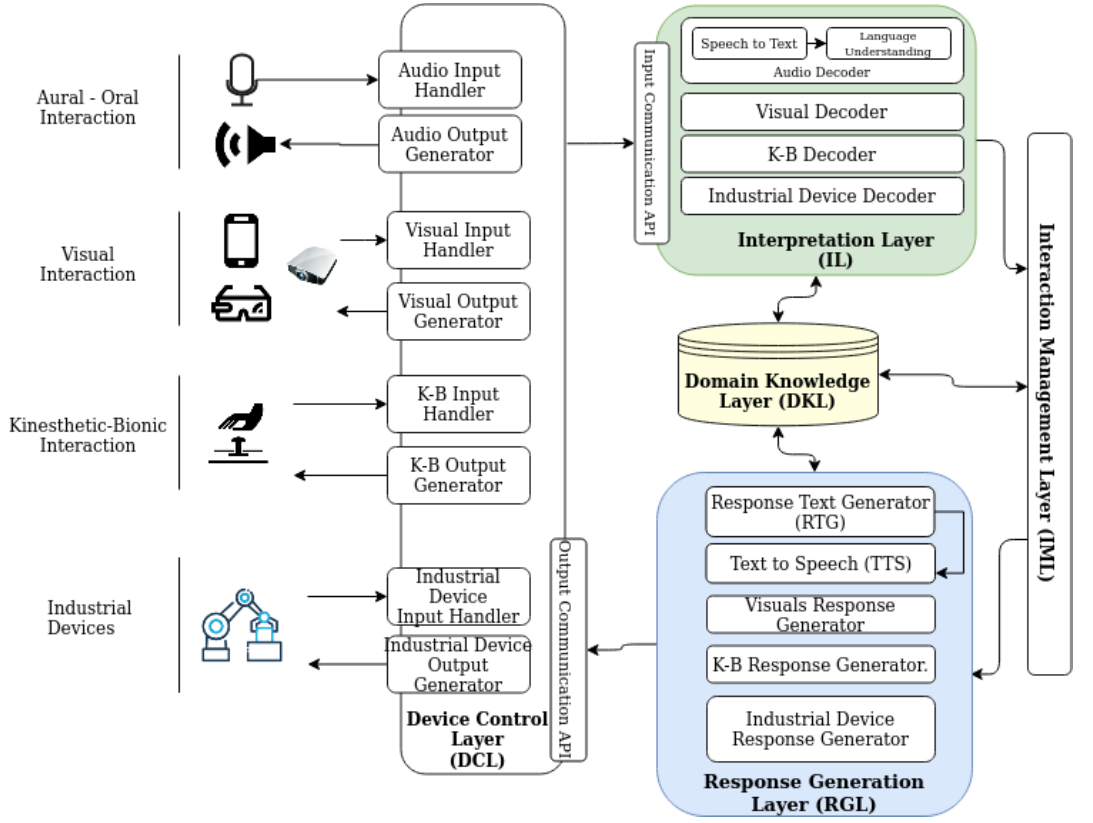
Figure 2. Architecture for the Interactive eXtended Reality (XR)